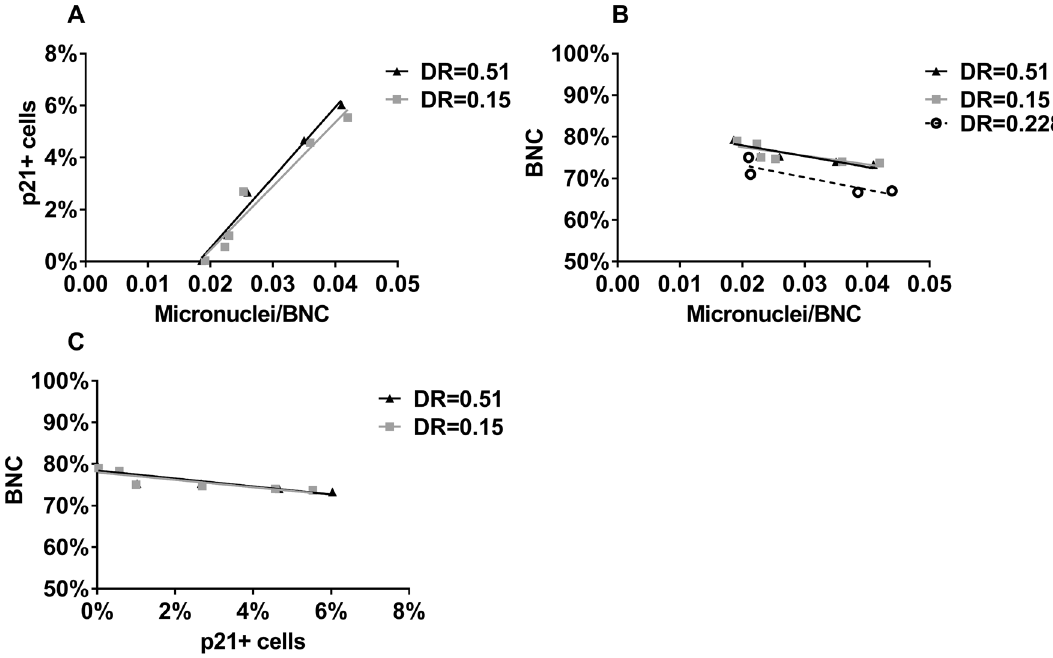
Figure 13. Frequencies of ( a ) p21-positive cells and BNC ( b ) versus frequencies of MN. Frequencies of ( c ) BNC versus those of p21-positive cells. Dose rate (DR) is expressed in Gy/min.